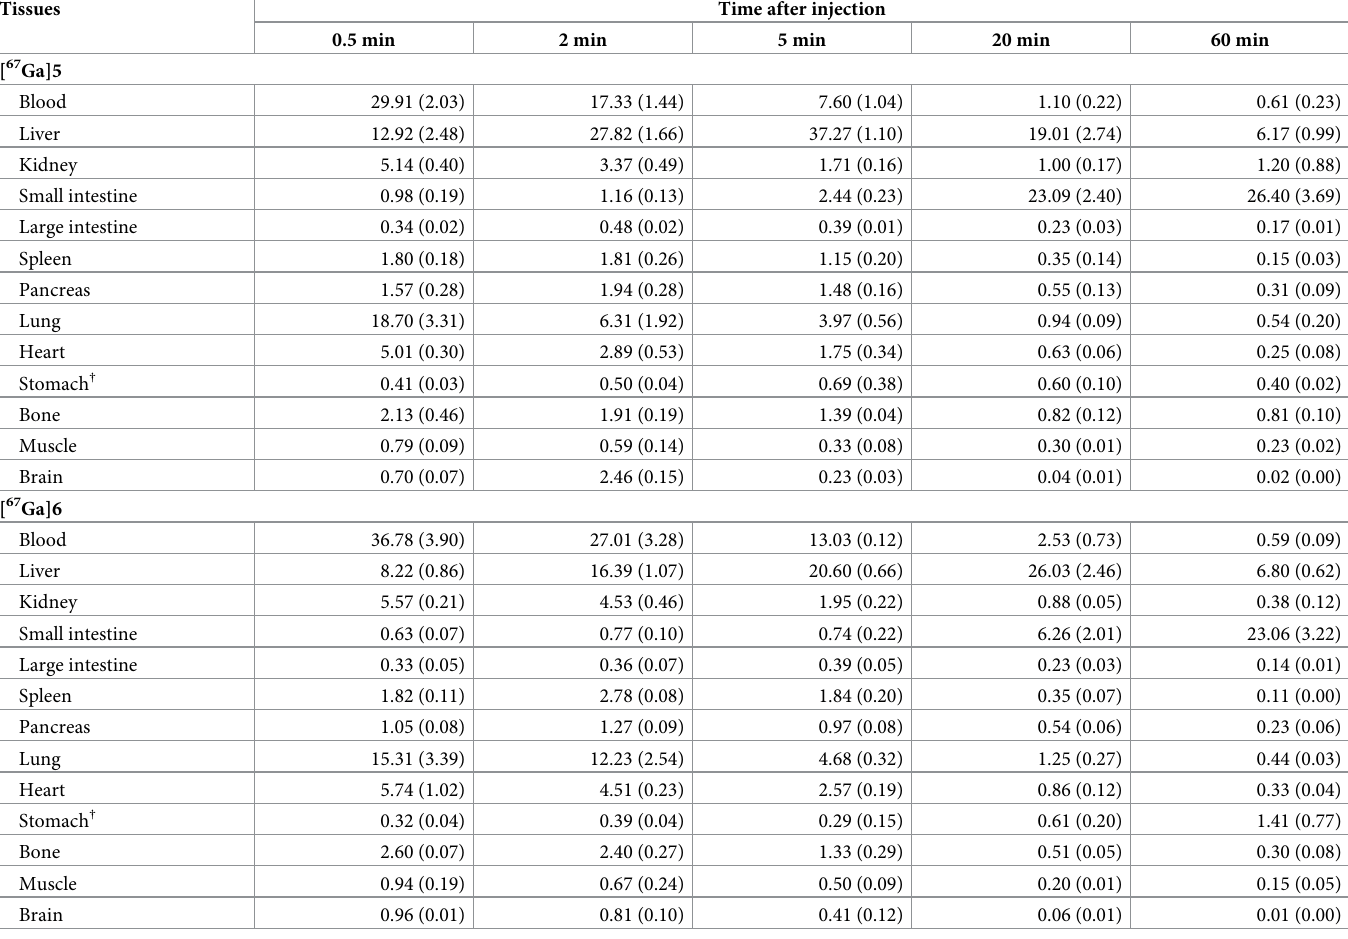
Data were presented as %injected dose/gram tissue. Each value represents mean (SD) for three mice. † presented as